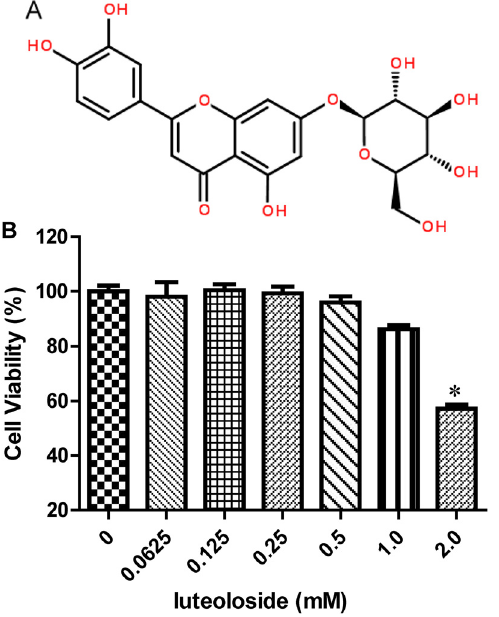
Fig 1. The molecular structure of luteoloside and its effects on RD cell viability. (A) The molecular structure of luteoloside. (B) Luteoloside was diluted as various concentrations as indicated in triplicate. The cytotoxicity of the compound was determined by MTS assay after drug-incubation for 48 h. The viability of cells upon DMEM medium without luteoloside (0 mM) was set as 100%. Data shown are the means ± SE from 6 independent measurements ( n = 6). Asterisk meant the data differed from the blank (0 mM) significantly at P < 0.05 level according to t -test.